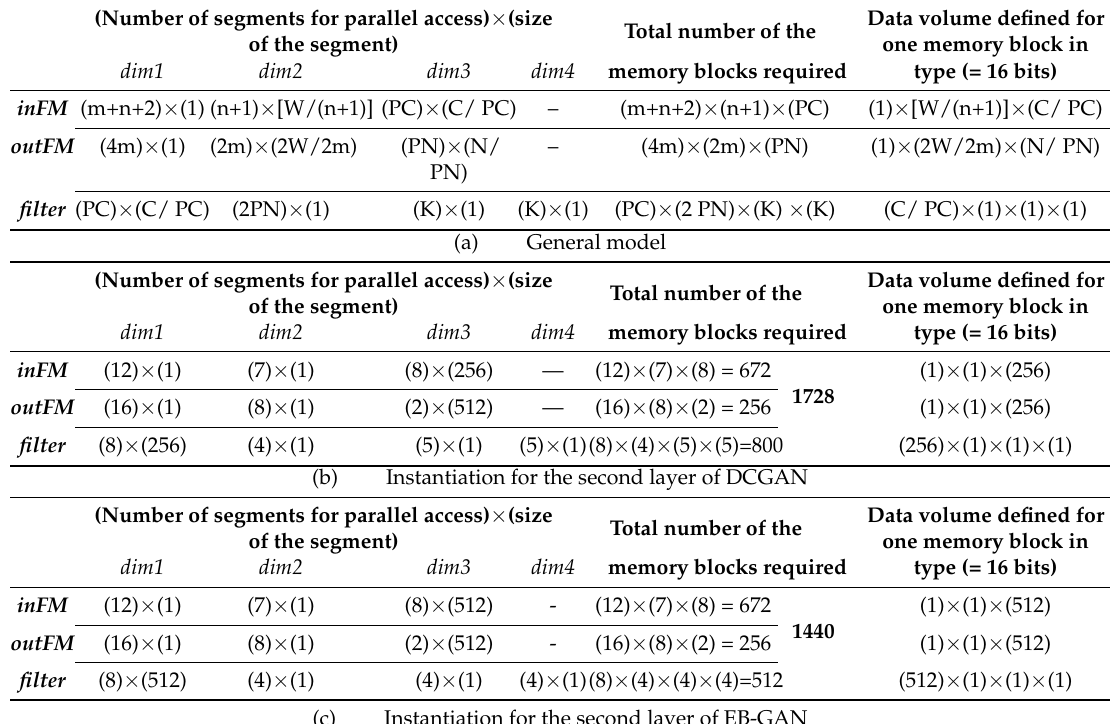
Figure 13. An illustration of memory partition. Table 3. Specifications of memory